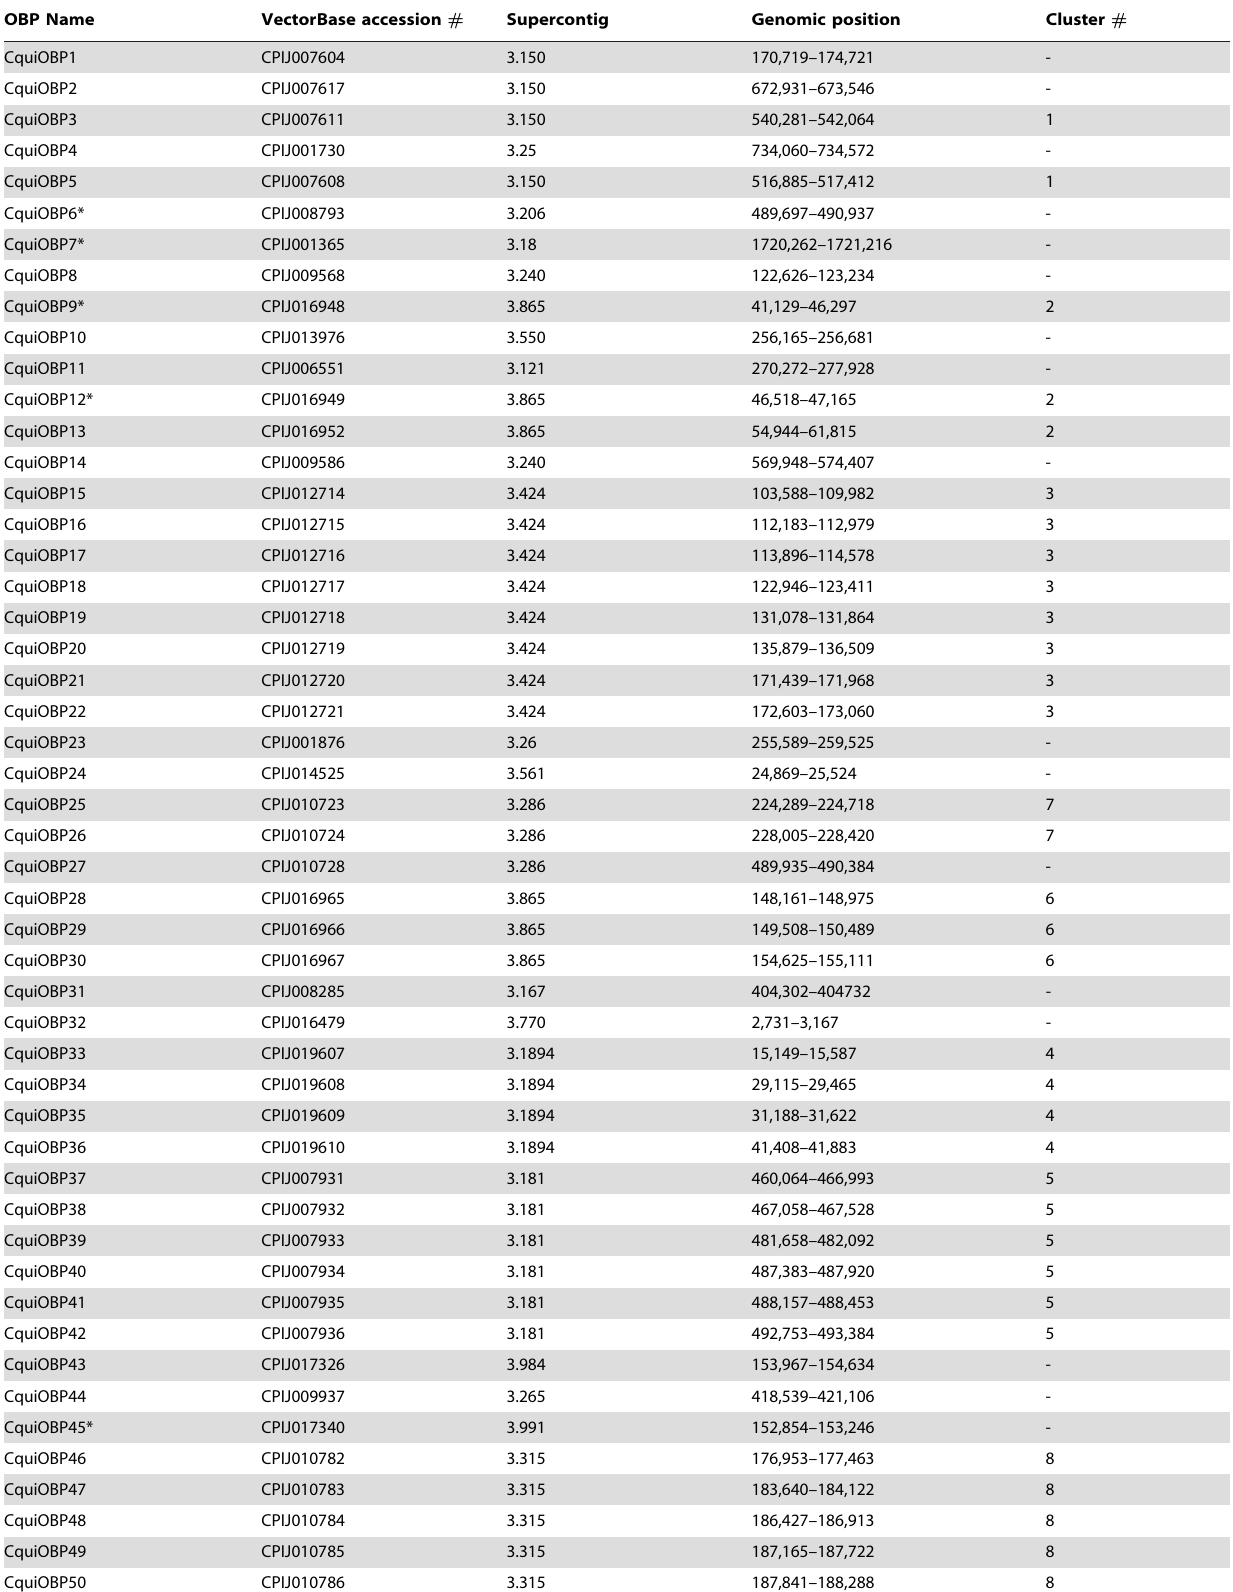
Table 3. Genomic organization of Cx. quinquefasciatus OBP